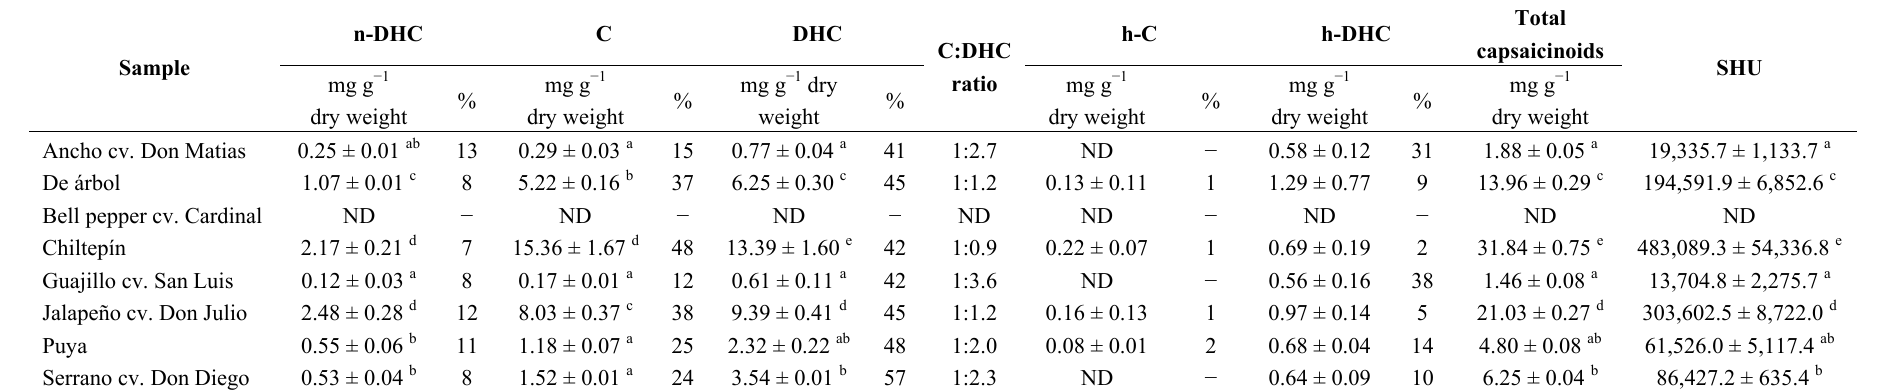
Table 1. Content of capsaicinoids in chili samples grown in an environment without thermal stress. Nordihydrocapsaicin (n-DHC), capsaicin (C), dihydrocapsaicin (DHC), homocapsaicin (h-C) and homodihydrocapsaicin (h-DHC); SHU = Scoville heat units. Content of nordihydrocapsaicin and homodihydrocapsacin were calculated as equivalents of dihydrocapsaicin; the content of homocapsaicin was calculated as equivalents of capsaicin. Means in the same column followed by di ff erent letters (a–e) were signi fi cantly di ff erent by Tukey’s test at p ≤ 0.05. ND = not detected.